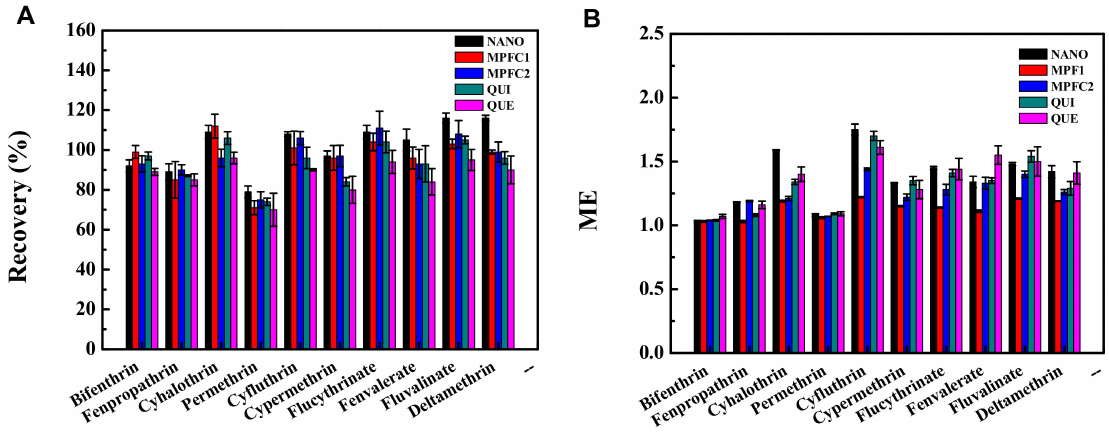
Figure 3. ( A ) The effect of different purification columns on the recovery rate of pyrethroid pesticides in a complex matrix (greengrocery) ( n = 3). ( B ) Matrix effect of pyrethroid pesticides in a complex matrix (greengrocery) under different purification